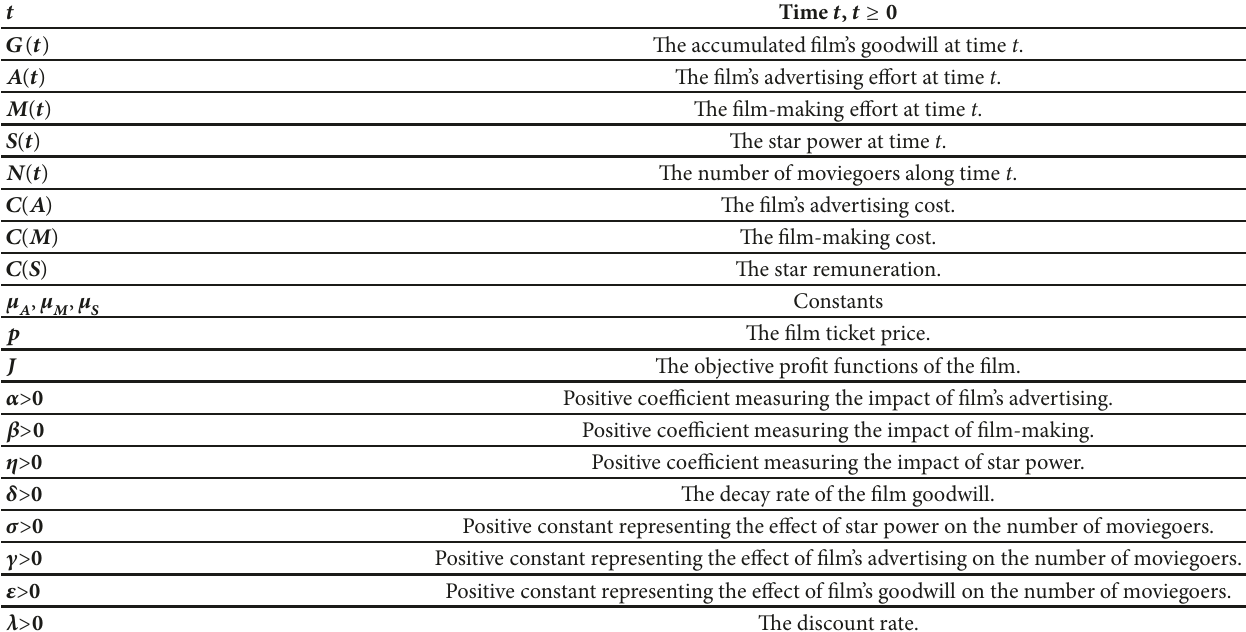
Table 1: Variables and definitions used in the